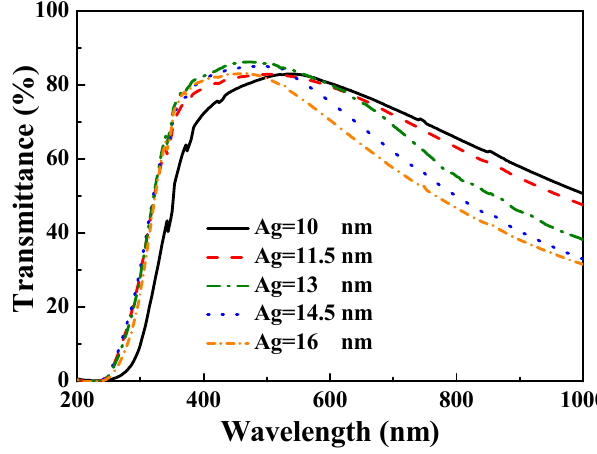
Figure 4. Ultraviolet-visible spectra of the α -IGZO/Ag/ α -IGZO triple-layer structure as a function of thickness of Ag film.